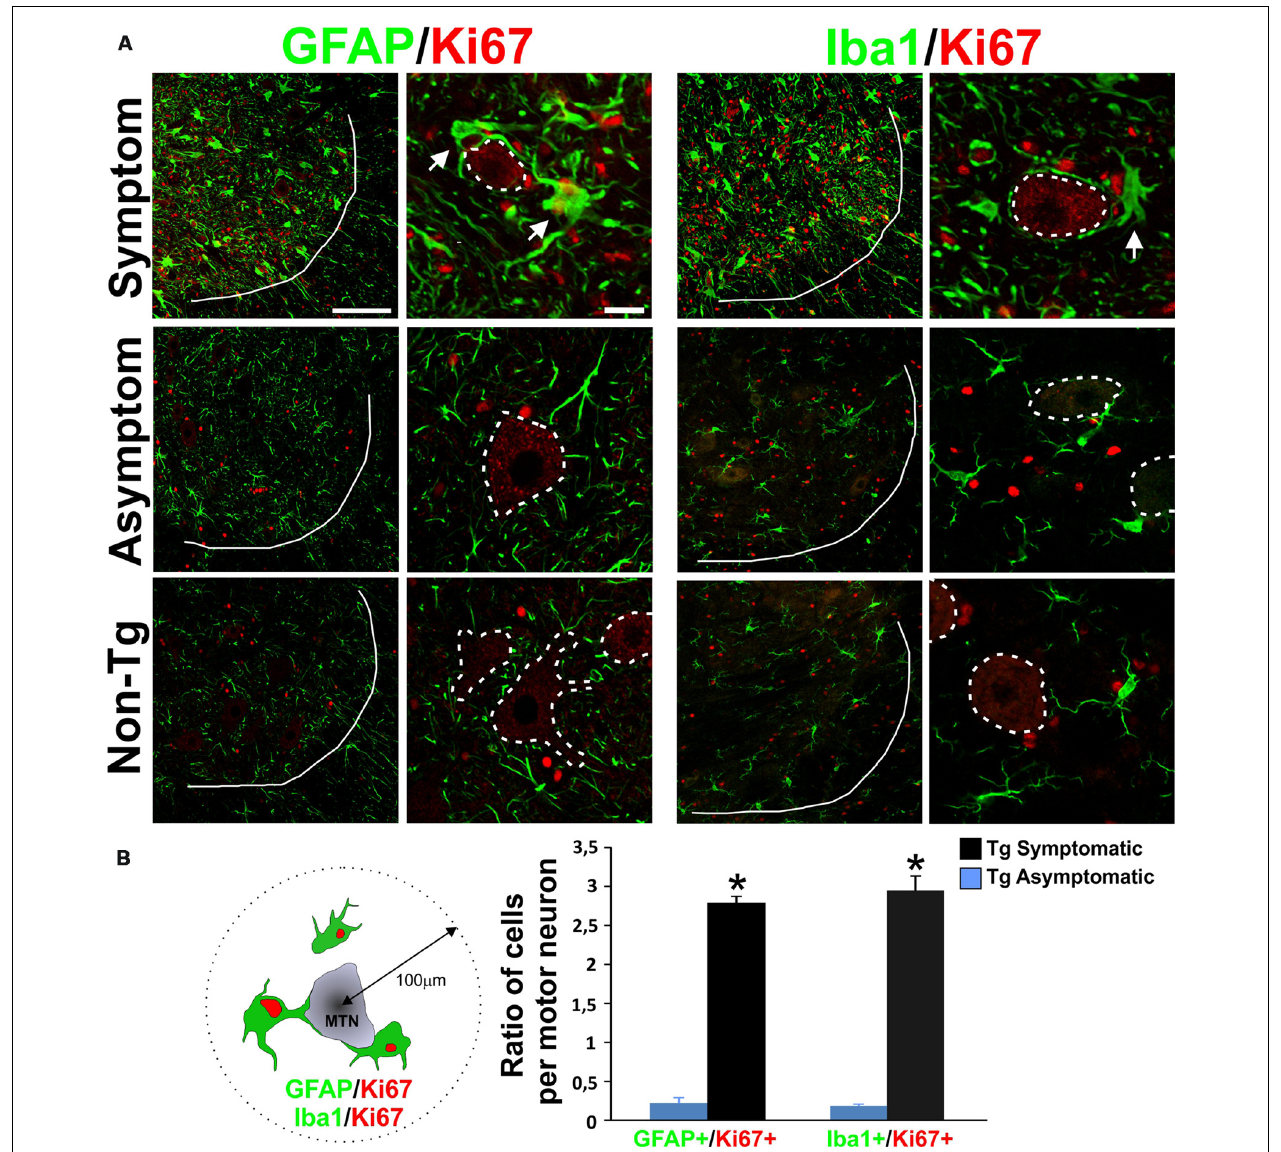
FIGURE 1 | Characterization of proliferative astrocytes and microglia in the degenerating lumbar spinal cord . (A) Photomicrographs showing GFAP/Ki67 and Iba1/Ki67 stained lumbar spinal cord sections measured in symptomatic (upper panels), asymptomatic (middle panels) SOD1 G93A rats, and non-transgenic rats (lower panels). Low magnification panels show the notorious increase in the number of Ki67 + red nuclei and the appearance of large GFAP + and Iba1 + cells (green) in the symptomatic rats, as compared to low cell proliferation in asymptomatic or non-Tg rats. A white line indicates the border between white and grey matter. The high magnification images show that GFAP/Ki67 and Iba1/Ki67 cells are typically